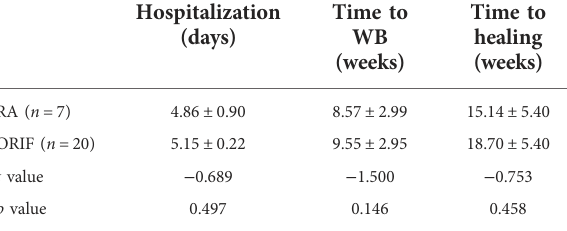
TABLE 2 Comparison of follow-up data between two groups (`x±s).